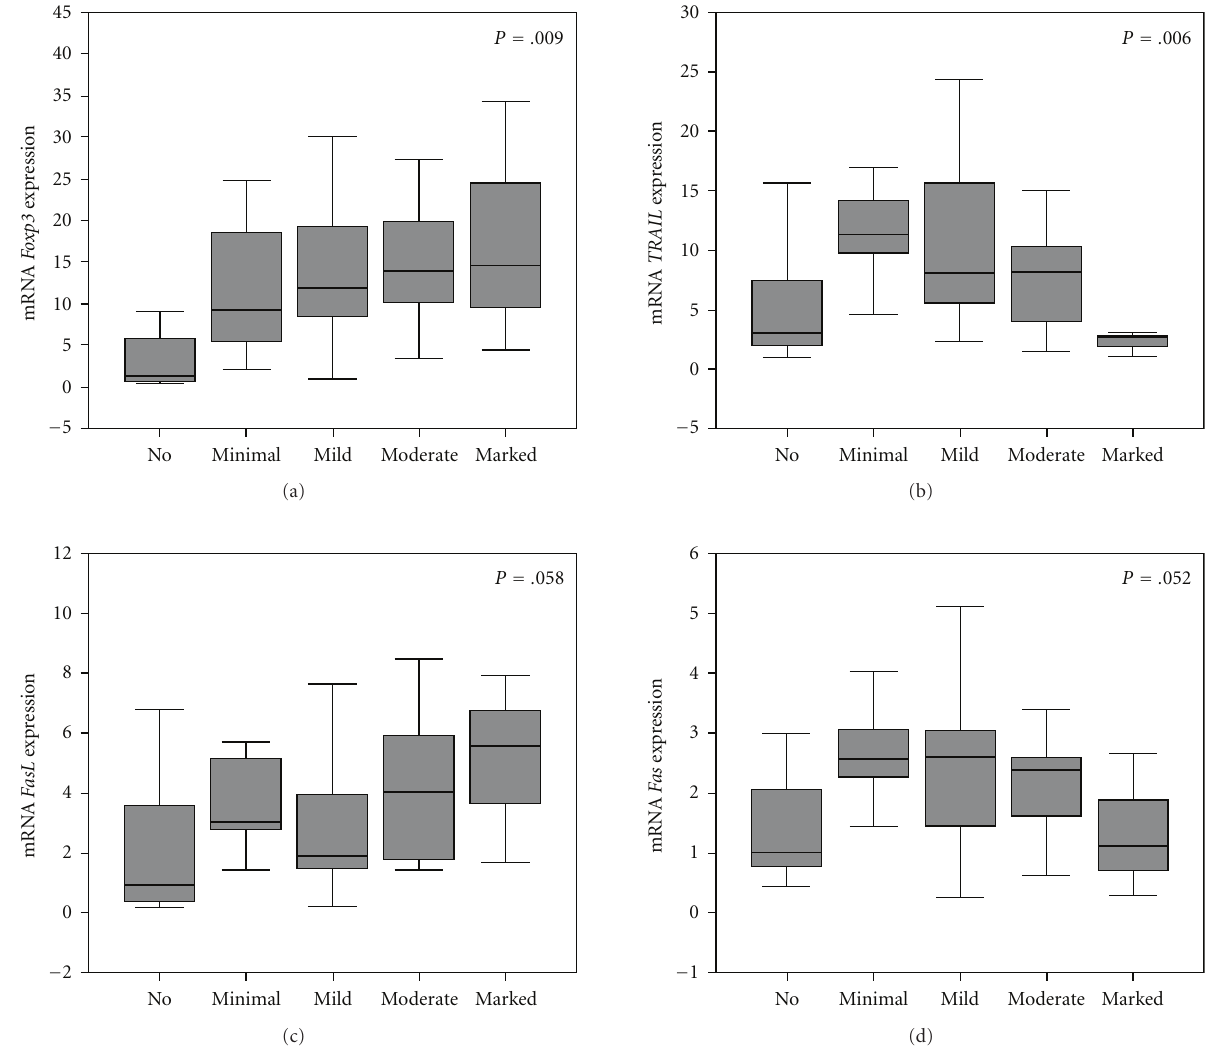
Figure 3: Boxplot diagrams presenting the expression of Foxp3 and apoptosis mediators according to the intensity of liver inflammation (classification as presented in Section 2). Abscissa corresponds to relative mRNA expression. The pattern of expression in the Foxp3 diagram followed also by FasL , but not by Fas and TRAIL . P value in each diagram refers to Kruskal-Wallis H